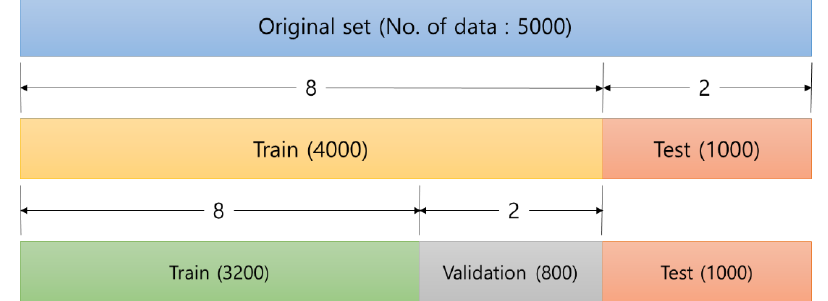
Figure 9. Dataset split diagram.